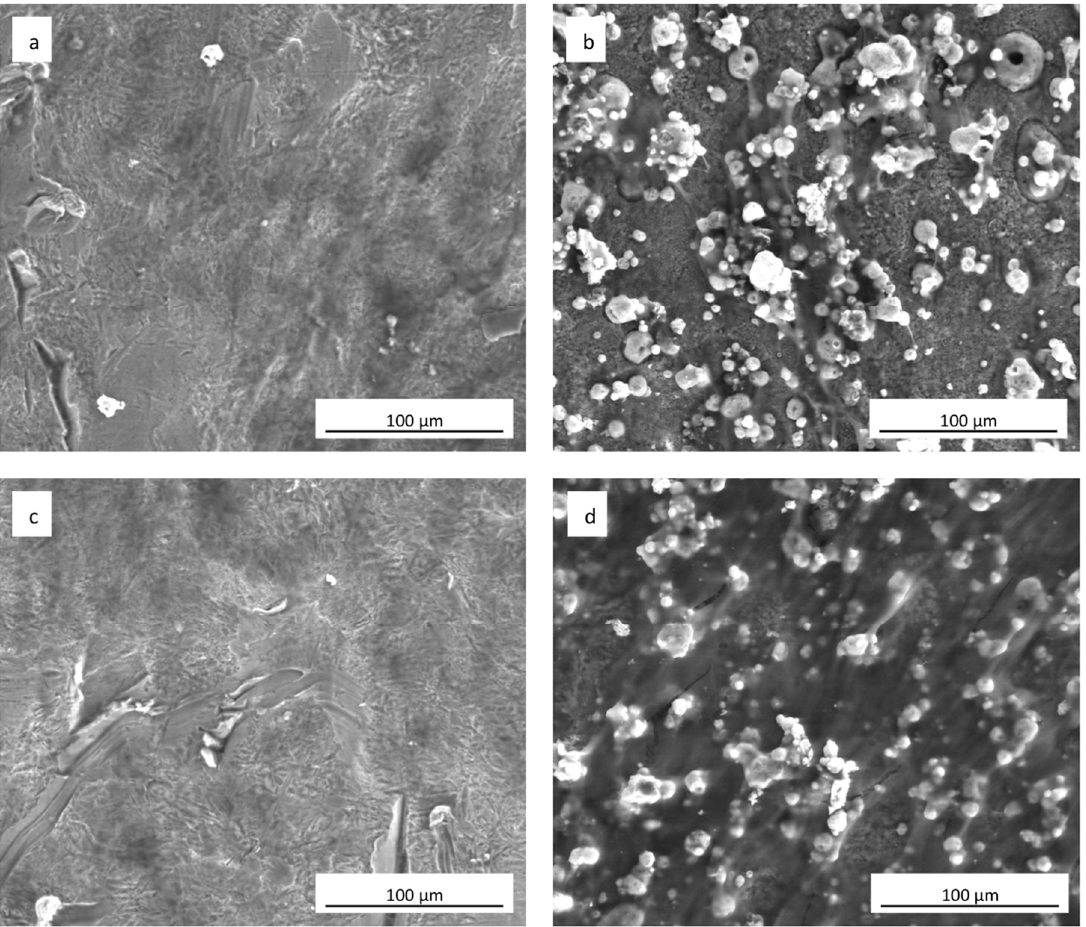
Figure 6. SEM images (1000 × magnification) of hADSCs grown for 21 days on ( a ) uncoated cpTi in DMEM High Glucose; ( b ) sphene-coated cpTi in DMEM High Glucose; ( c ) uncoated cpTi in Osteogenic Differentiation Medium; ( d ) sphene-coated cpTi in Osteogenic Differentiation Medium.